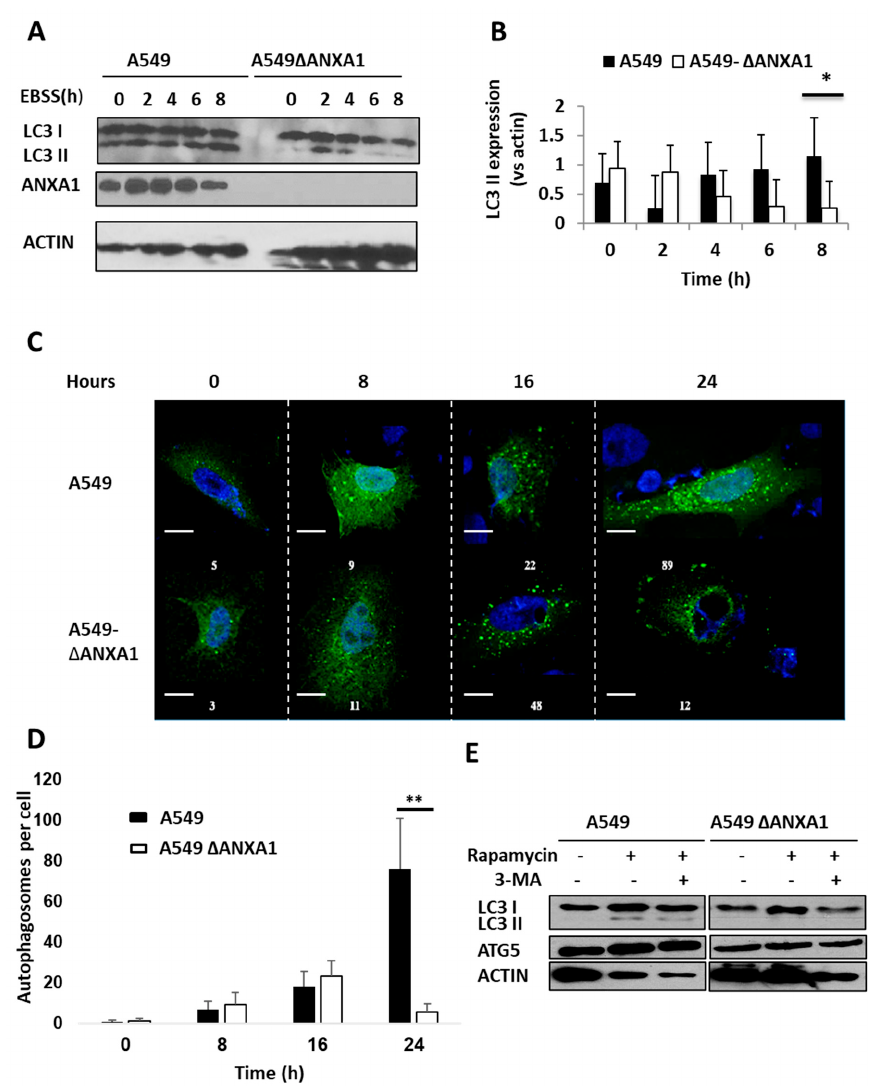
Figure 5. mTOR inhibitors and starvation induce autophagy in A549 but not in A549- Δ ANXA1. ( A , B ) A549 cells and A549- Δ ANXA1 cells were treated with EBSS over various time points (0, 2, 4, 6 and 8 h). The cell lysates were then collected and a Western blot analysis using LC3 antibody was performed. ( C , D ) The number of autophagosomes (labeled by anti-LC3-GFP) was counted in A549 cells and A549- Δ ANXA1 cells after being treated with EBSS at various time points (0, 8, 16 and 24 h). The autophagosomes were labelled using anti-LC3-GFP (green) and the nuclei of the cells were stained using DAPI (blue). Autophagosomes were counted per cell in at least 3–5 cells per view, and the error bars and significance data were generated from 3 fields of view. ( E ) Western blot analysis was performed after cells were treated with 200 nM of rapamycin and 0.75 mg/mL of 3-Methyladenine (3-MA) for 24 h. Data is representative of three independent experiments. * 0.01 < p < 0.05, ** p < 0.01. Scale bars = 25 µ m in all